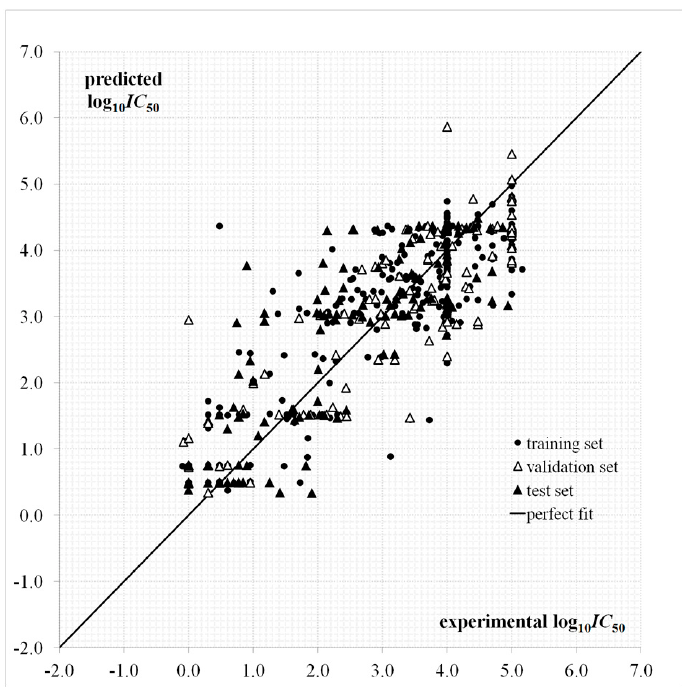
Figure 2. Predicted and experimental log IC 50 values according to the quantitative structure-activity relationship (QSAR) of Equation (1).